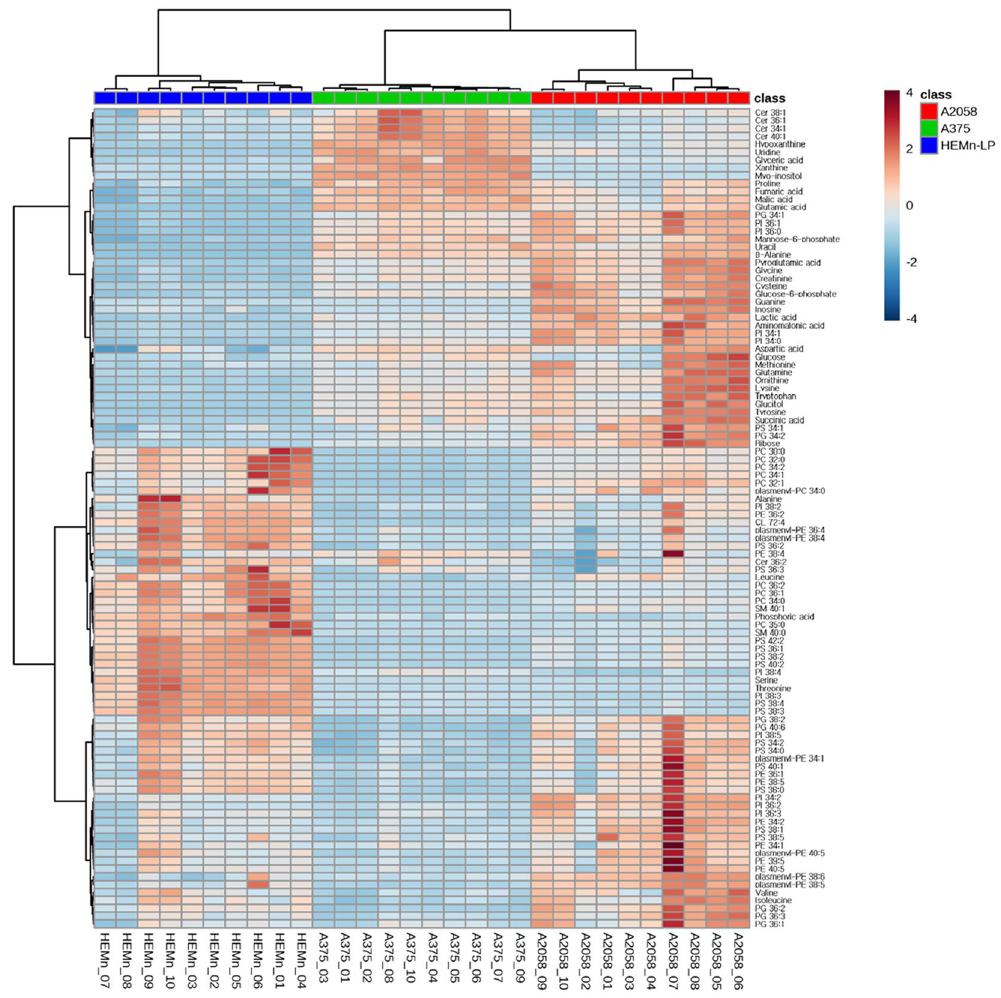
Figure 1. Heatmap representing the relative levels of metabolites and lipids in the three different cell types (HEMn-LP, A375,